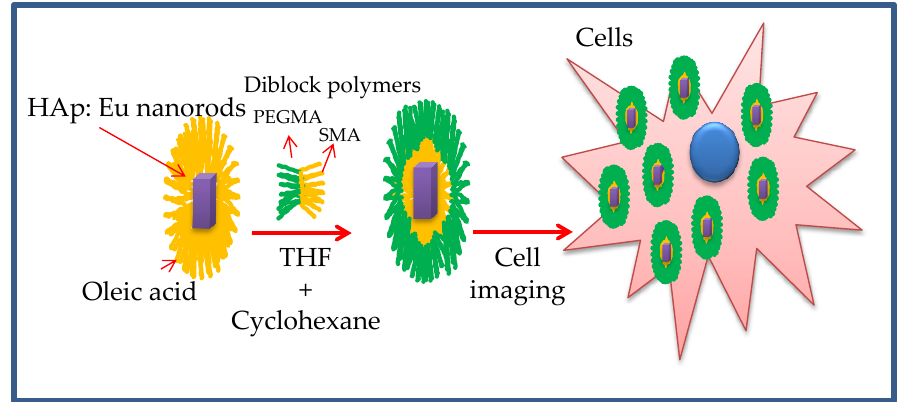
Figure 6. Surface modification of oleic acid coated fluoridated hydroxyapatite (FAp) with amphiphilic molecules via hydrophobic interactions and cell imaging application. Adapted from [95], Royal Society of Chemistry, 2013.